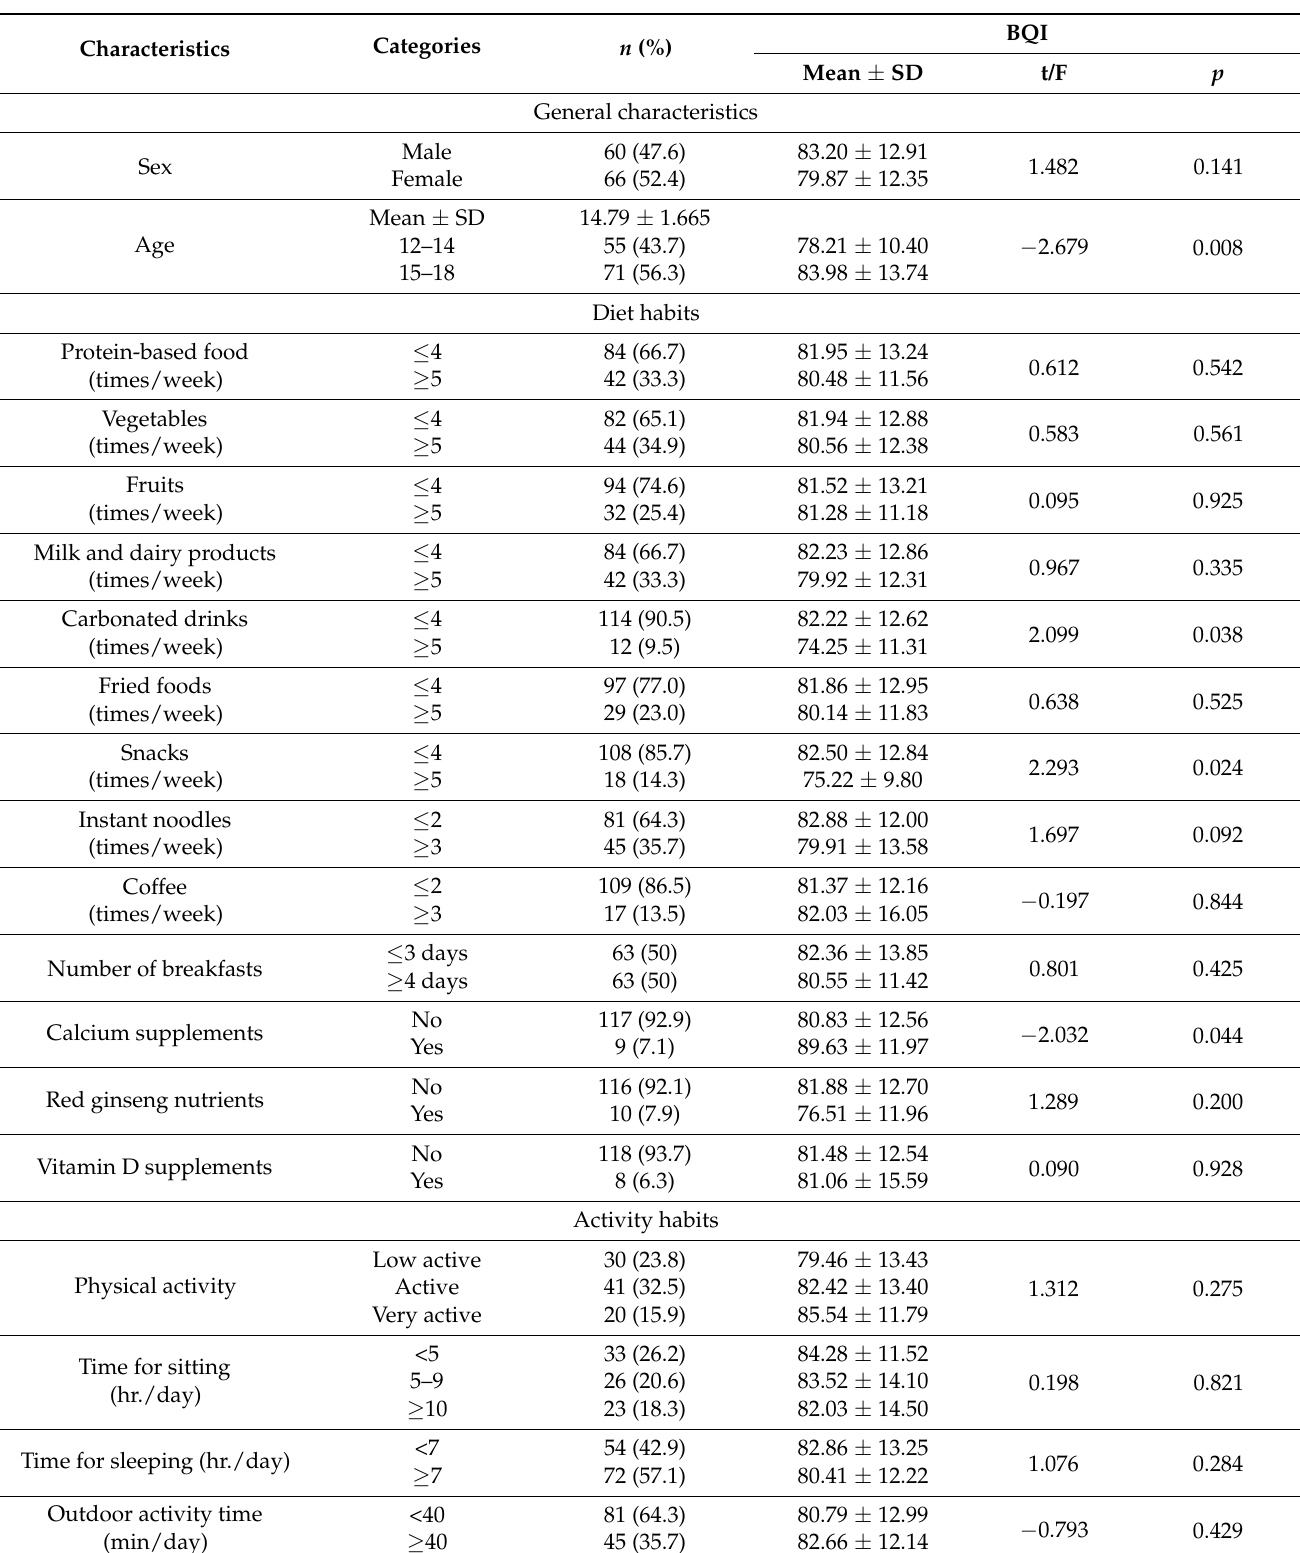
Table 1. Difference of BQI (bone quality index) by characteristics of adolescents ( n =